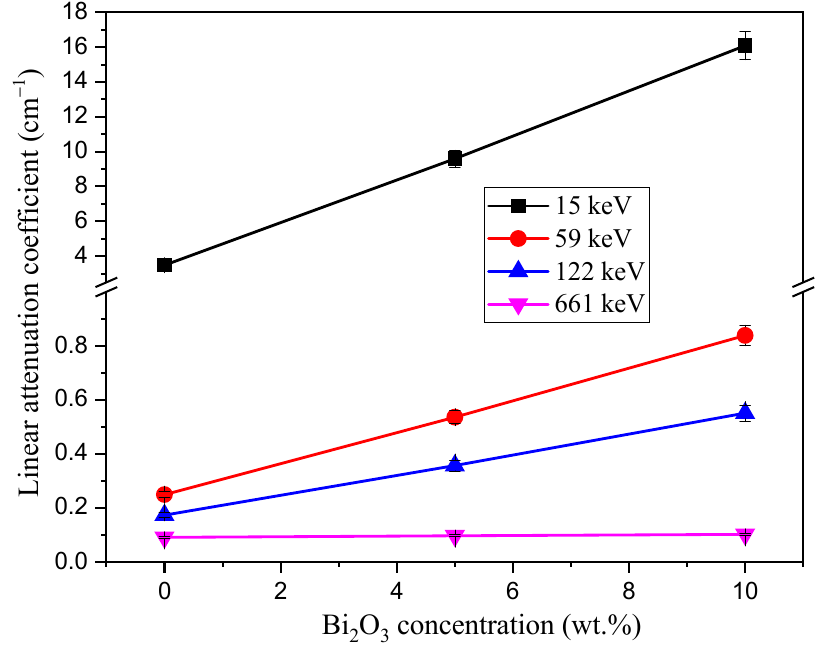
Figure 3. Influence of Bi 2 O 3 concentration on the LAC of the synthesized composite.